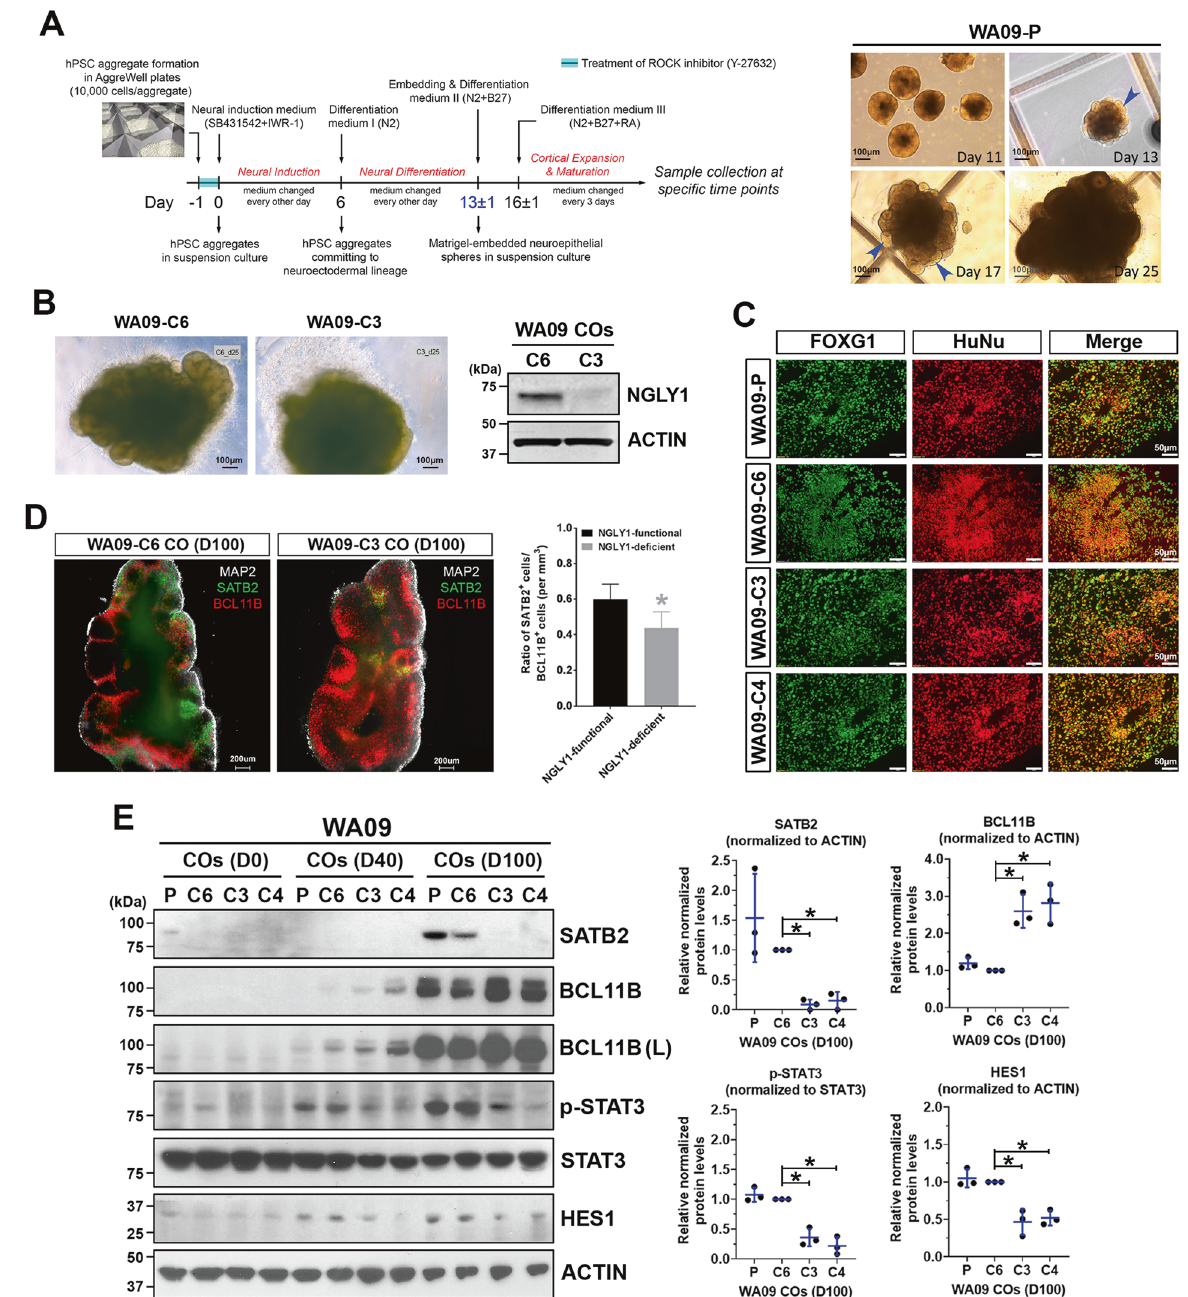
Fig. 2 NGLY1-de fi cient COs differ from NGLY1-functional COs in their capacity to form upper-layer neurons and show alterations in critical signaling needed for radial glia. A The schematic illustration of the protocol for CO development ( left panel ) used in our studies and the morphological representations of WA09-P COs at the indicated time points along development ( right panel ). Blue arrowheads: neuroepithelial buds, WA09-P: parental WA09 hESCs. B The representative morphology of NGLY1-functional and -de fi cient WA09 hESCs COs with 25 days of development. The expression of NGLY1 in the WA09-C6 (NGLY1-functional) and WA09-C3 (NGLY1-de fi cient) COs was con fi rmed by western blotting. C Both NGLY1-functional and -de fi cient COs positively stained for forebrain marker FOXG1 and human nuclear antigen. WA09-P and WA09-C6: NGLY1-functional. WA09-C3 and WA09-C4: NGLY1-de fi cient. D The representative images of optical sections taken for CO samples with SATB2, BCL11B and MAP2 staining; upper-layer (SATB2 + ) neurons and deeper-layer (BCL11B + ) neurons ( left panel ). The ratios of SATB2 + and BCL11B + cell counts in COs ( n = 4 for each NGLY1 condition, * p < 0.05, t -test) for each NGLY1 condition ( right panel ). WA09-C6 CO: NGLY1-functional CO. WA09-C3 CO: NGLY1-de fi cient CO. D100: 100 days of CO development. E The expression of SATB2, BCL11B, phosphorylated STAT3, and HES1 detected by western blotting with densitometry analysis in NGLY1 functional and -de fi cient COs with 0, 40, and 100 days (D0, D40, and D100) of development. P and C6: NGLY1-functional COs. C3 and C4: NGLY1-de fi cient COs. (L): long exposure. * p < 0.05, t